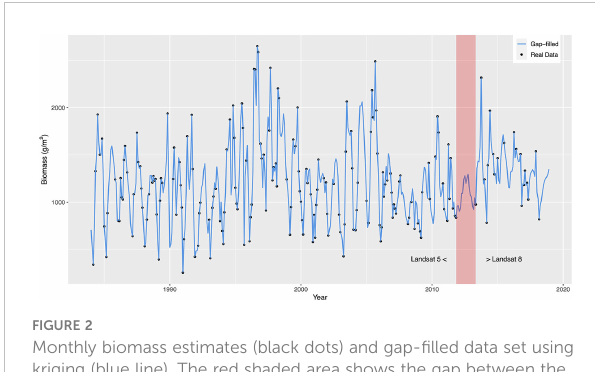
FIGURE 2 Monthly biomass estimates (black dots) and gap- fi lled data set using kriging (blue line). The red shaded area shows the gap between the operation of Landsat 5 and